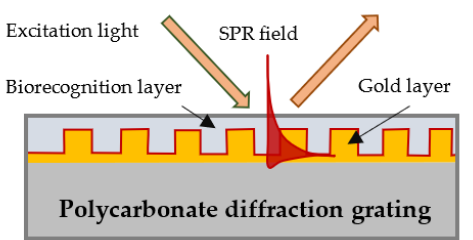
Figure 1. Surface plasmon wave excitation and a biochip-gilded diffraction grating with a layer of immobilized biomolecules.